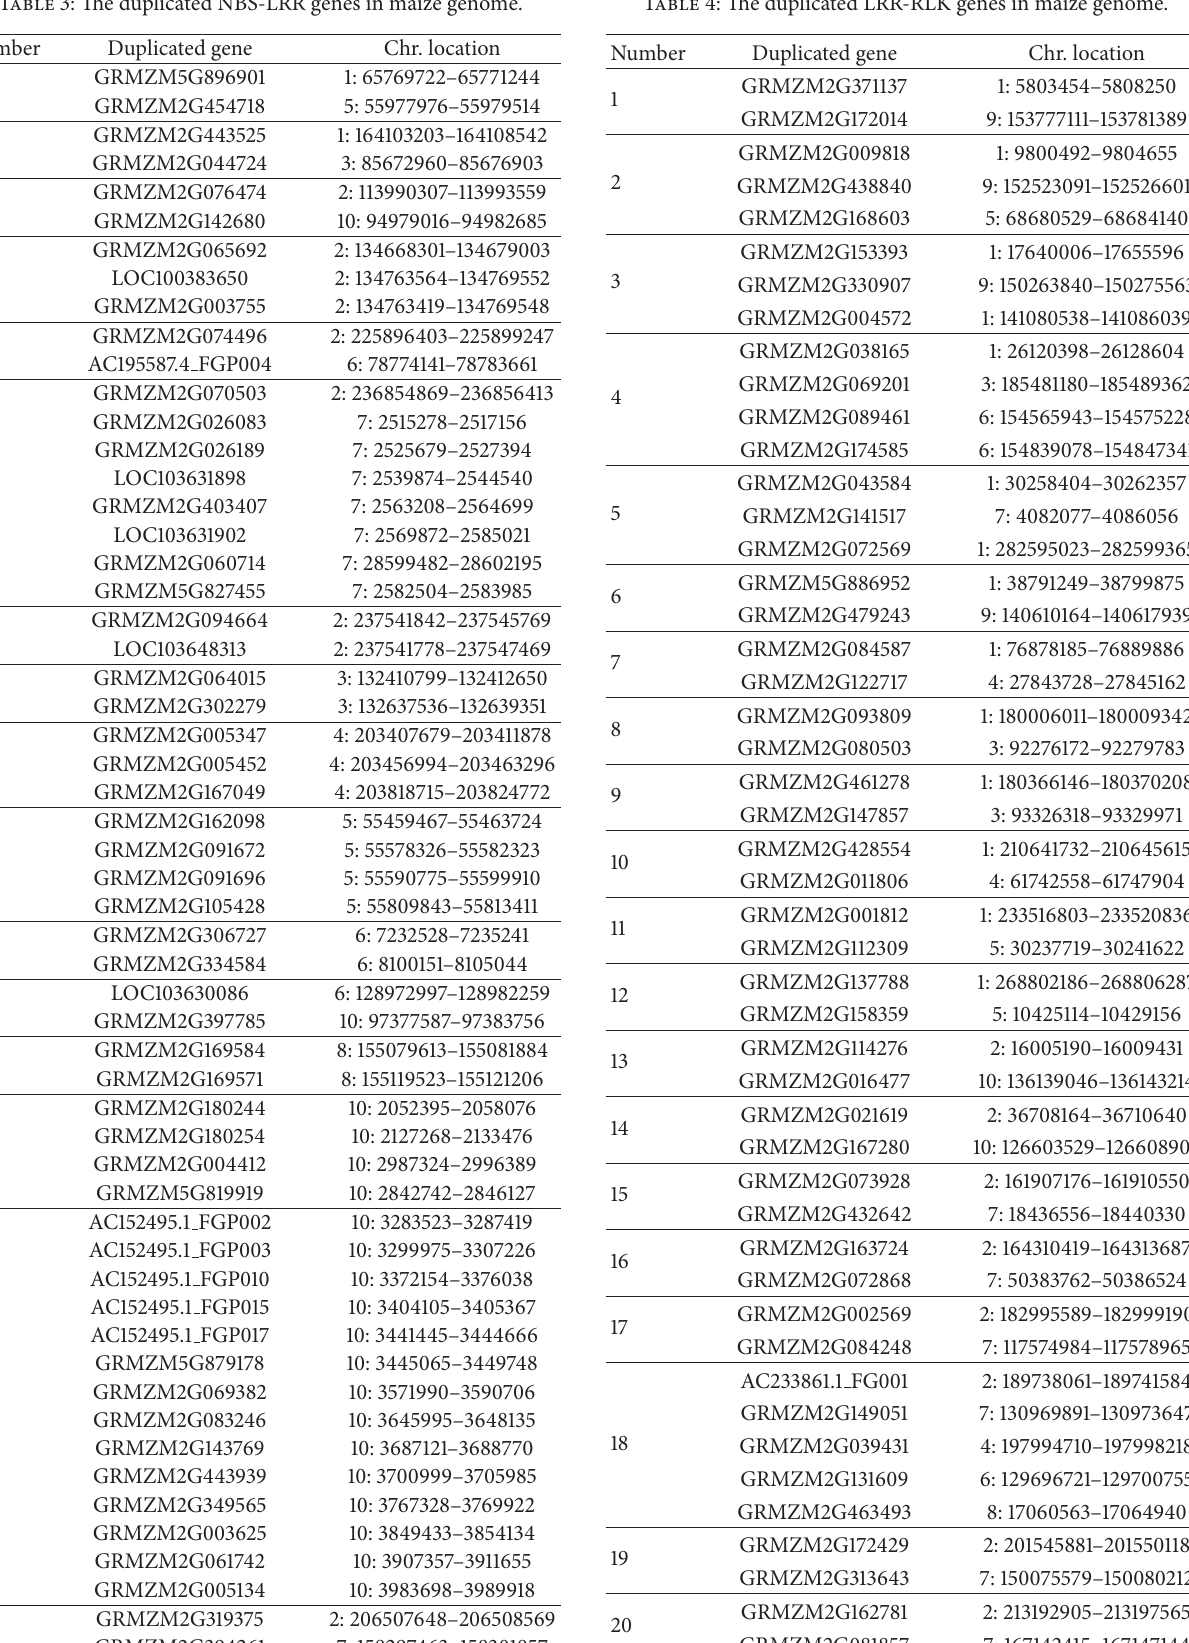
Table 3: The duplicated NBS-LRR genes in maize genome. Table 4: The duplicated LRR-RLK genes in maize